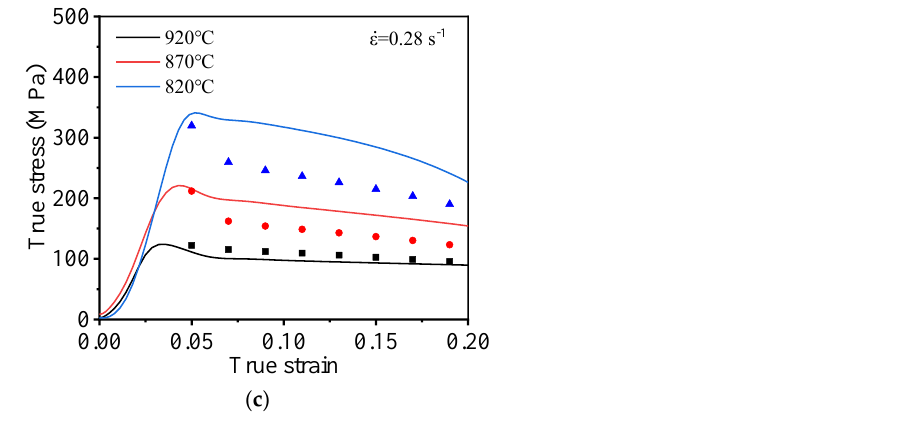
Figure 9. Experimental and predicted values at different deformation conditions: ( a ) 0.01 s −1 ; ( b ) 0.1 s −1 ; ( c ) 0.28 s − 1 . The temperature-compensated ε factor Z is corrected as follows.